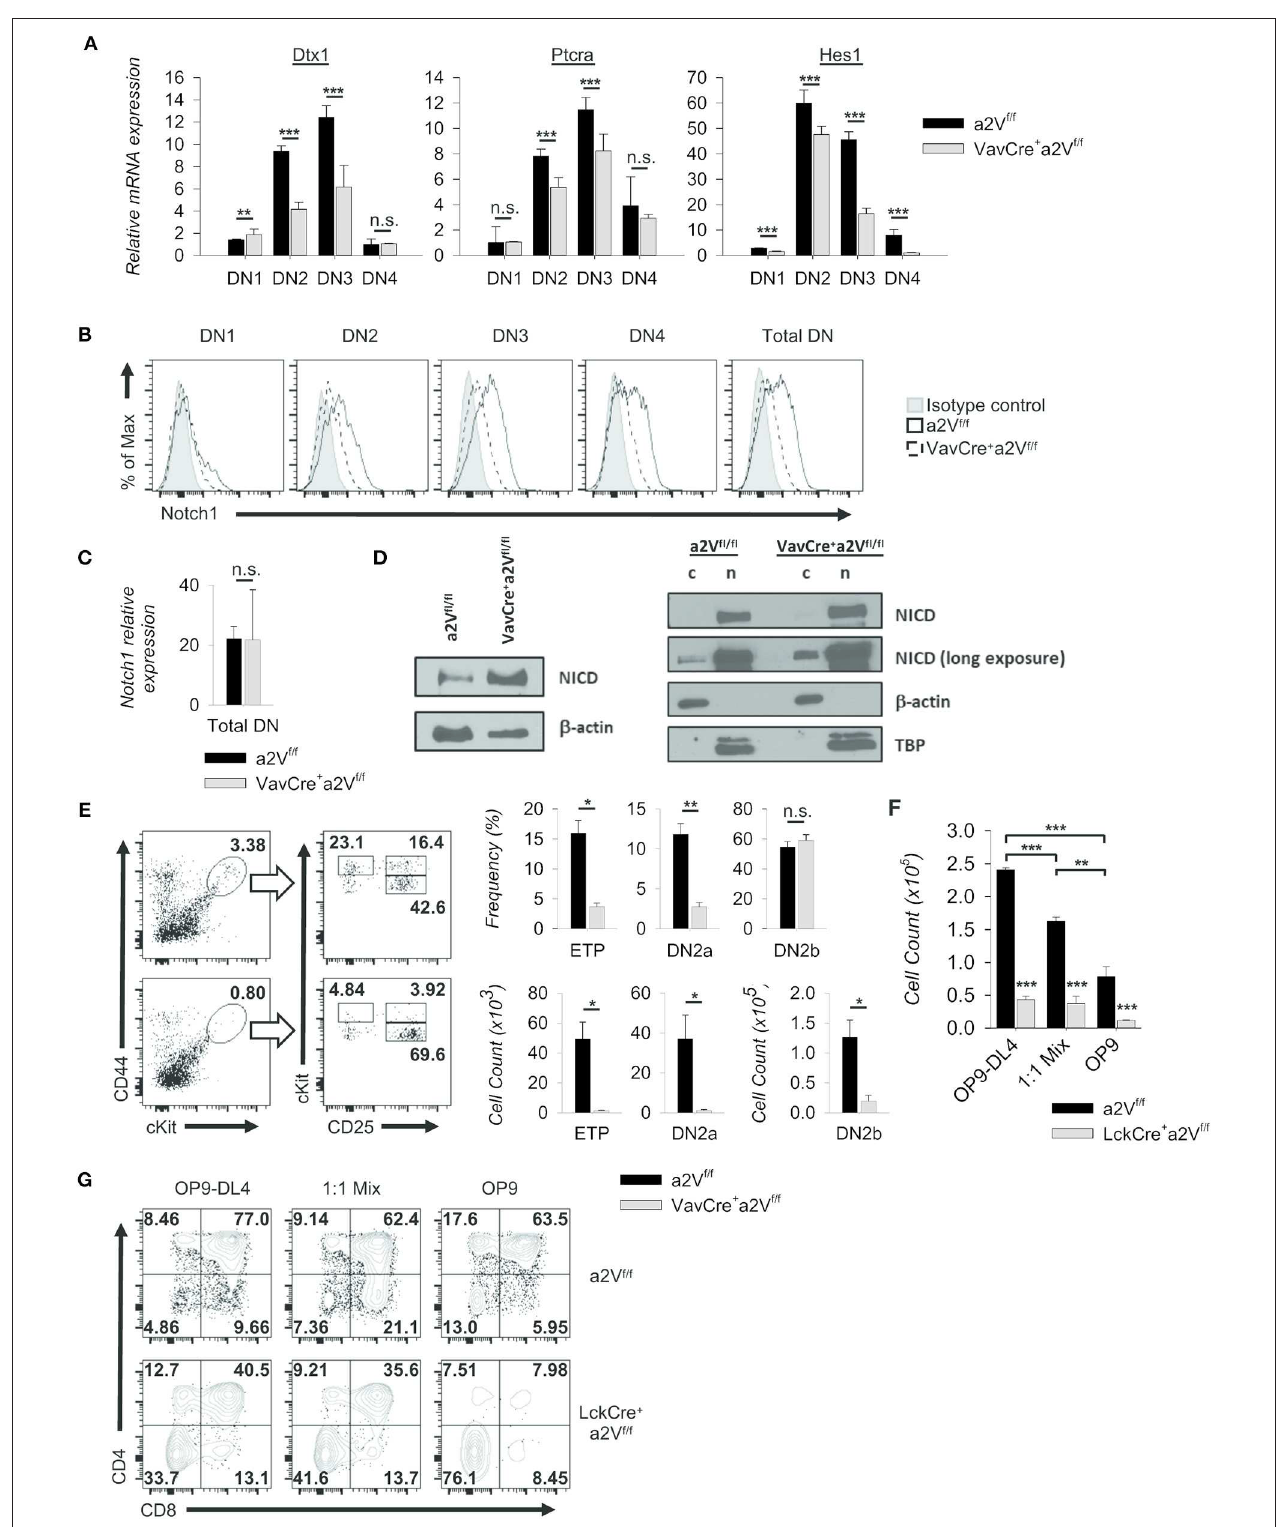
FIGURE 8 | Alteration of Notch1 signaling and developmental progression. (A) Expression of selected Notch1 target genes relative to GAPDH in sorted DN subpopulations (CD44 + CD25 − DN1; CD44 + CD25 + DN2; CD44 − CD25 + DN3; CD44 − CD25 − DN4) (Vav Cre a2V fl / fl and a2V fl / fl , n = 9 each group). Dtx1 and